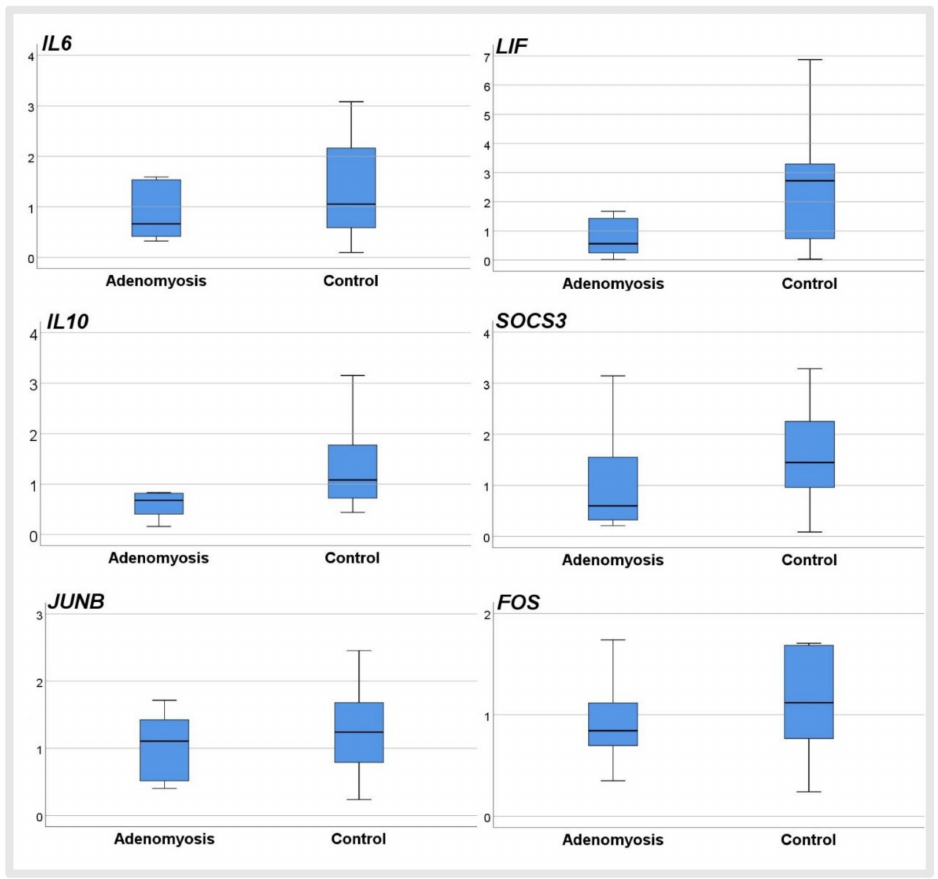
Figure 4. Relative expression levels of selected candidate genes in adenomyosis and control study groups. Selected genes were normalised to expression level of GAPDH and 18S rRNA reference